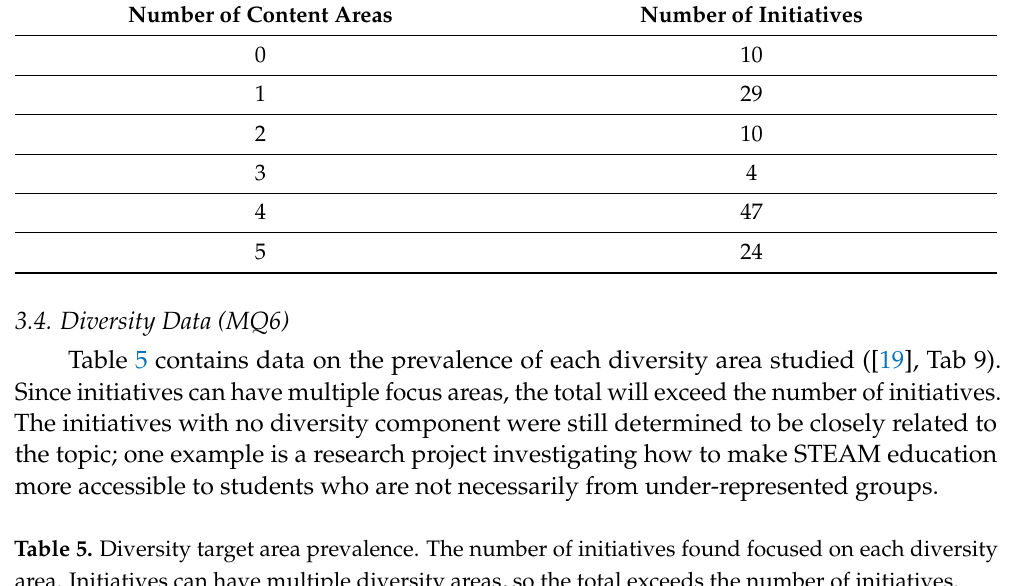
Table 4. Number of content areas prevalence. The number of initiatives with each number of content areas. For example, there are 29 initiatives with one content area. Number of Content Areas